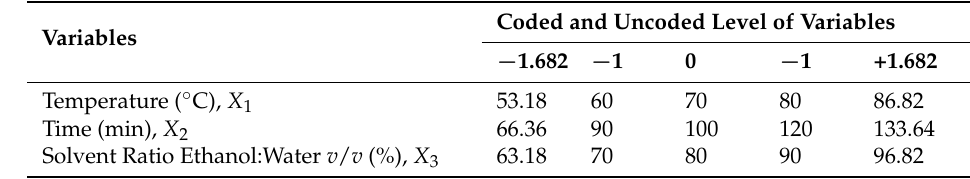
Table 5. Independent test variables and their coded and uncoded values for CCD